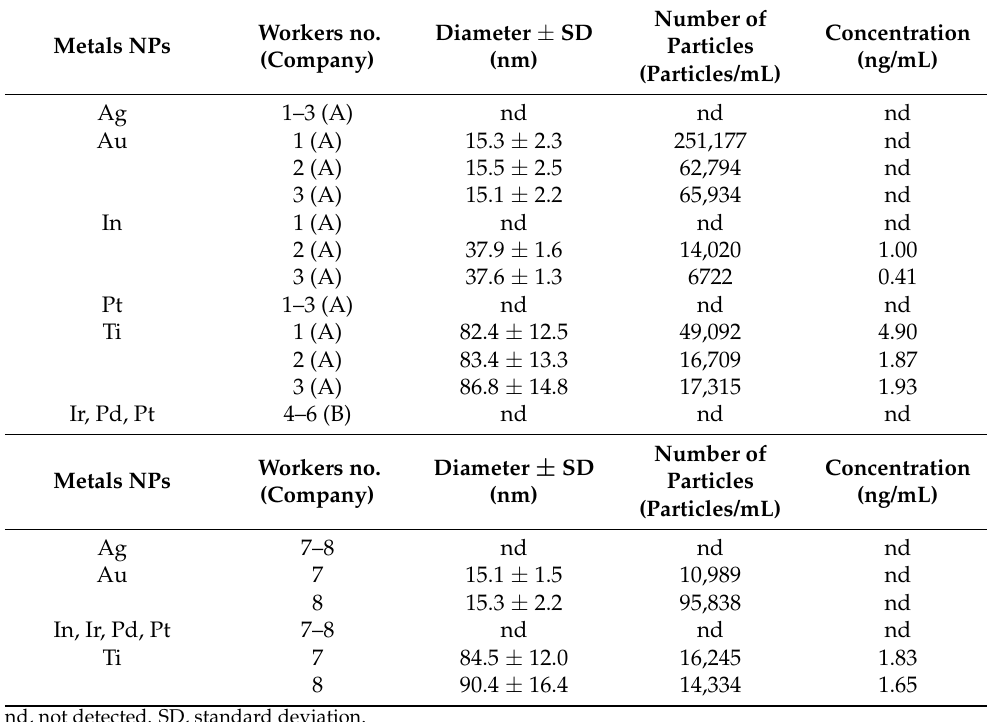
Figure 4. Workers urinary excretion profile of Ag nanoparticles (NPs) during one working week nd, not detected. SD, standard deviation. (1st–4th day).